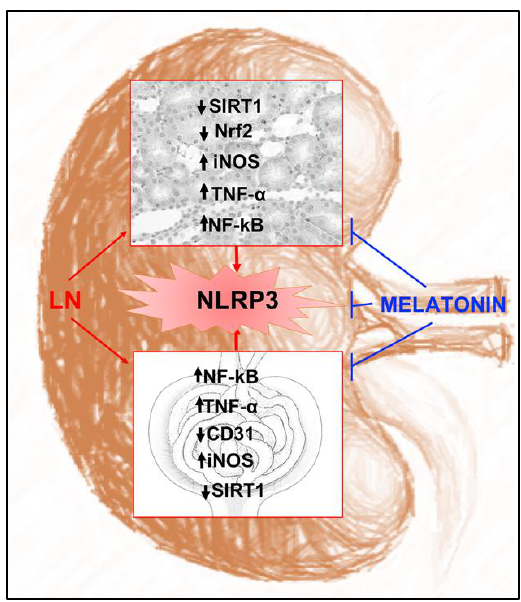
Figure 8. Melatonin protective effects against LN. Schematic representation of melatonin attenuation of kidney oxidative stress, inflammation and morphological alterations in pristane-LN mice.